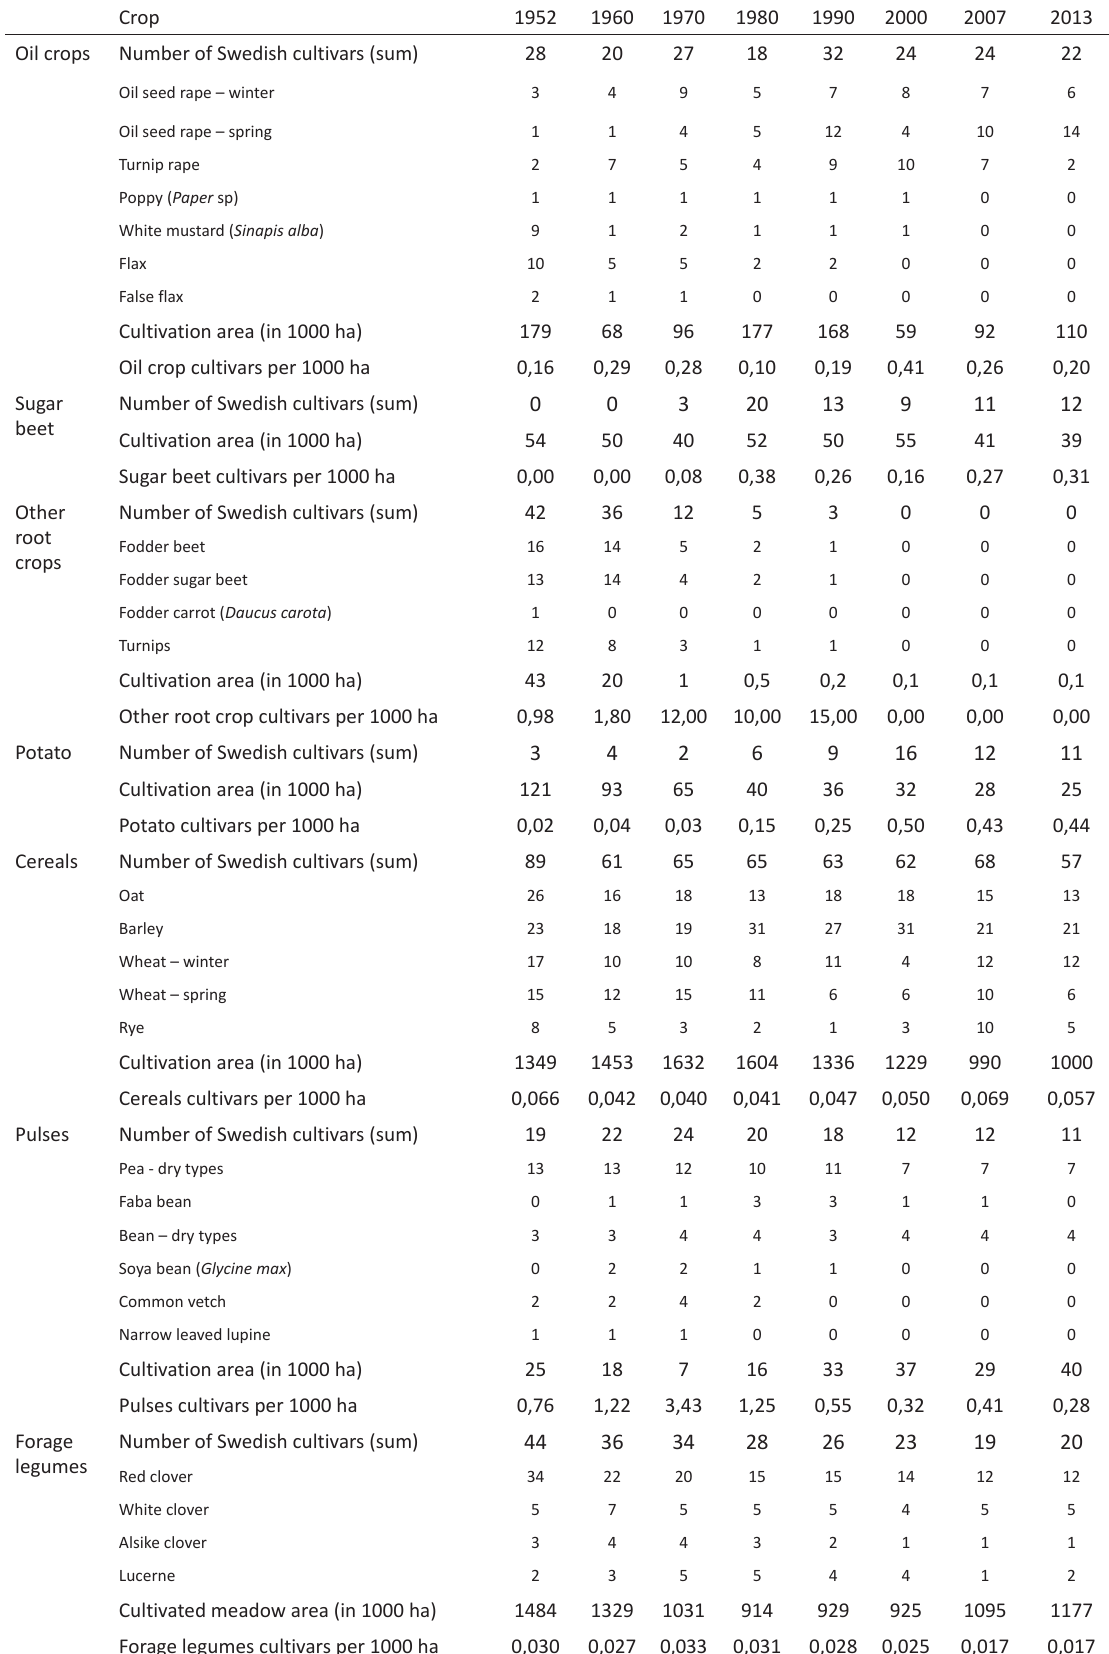
Table 3. Agricultural crops; number of Swedish bred cultivars on the official variety lists from 1952 to 2013, and cultivation area and number of cultivars per 1000 ha